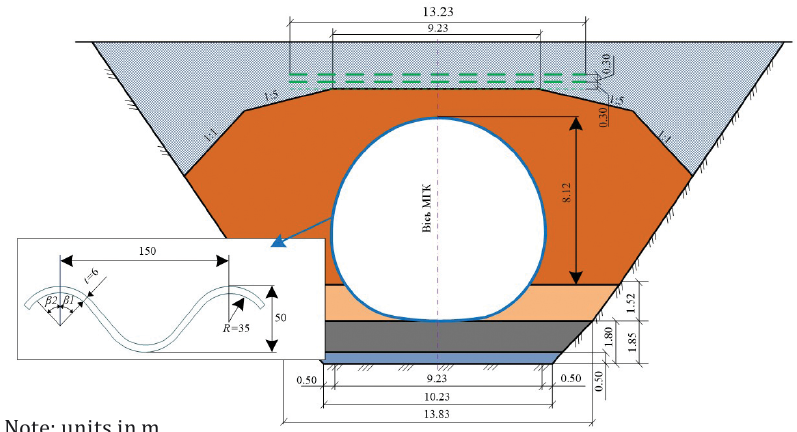
Figure 5. Cross-section of the construction with corrugated metal structures Note: units in